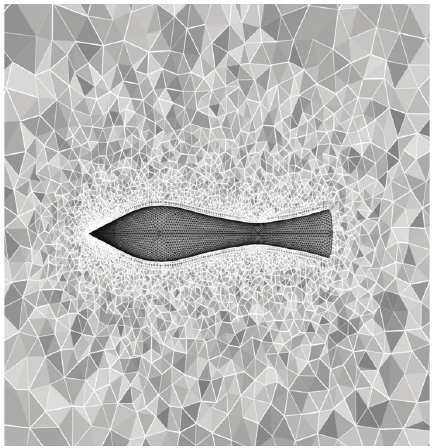
Figure 15: Waisted body and volume mesh.